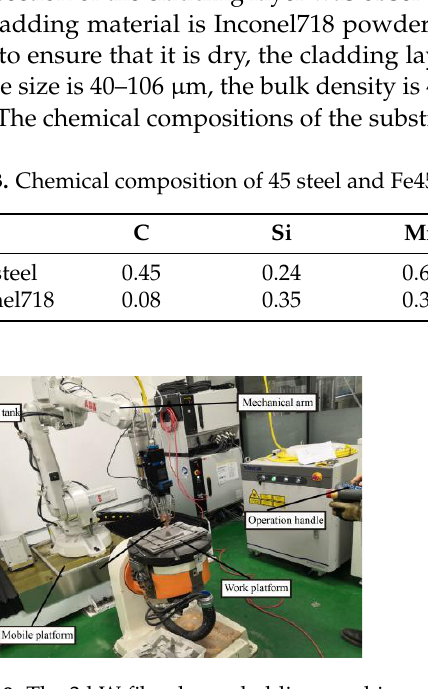
Figure 10. Super-depth-of-field microscope. Figure 11. Microscopic image of Inconel718 alloy powder. According to the previous experimental research, the distance between the nozzle and the surface of the worktable was adjusted to be 25 mm, the radius of the laser spot was 2 mm, the initial preheating temperature was set to 20 degrees, and argon (Ar) was used as the protective gas during the cladding process, shielding gas flow 6~10 L/min. 3.2. Experimental Design and Results During the laser cladding process, the matrix and the cladding powder absorb dif- ferent energy, resulting in different degrees of melting effect of the matrix and the powder. The partially melted matrix material will diffuse into the molten powder, which will have a certain dilution effect on the melted powder melt. We usually use the dilution rate to represent the diffusion result of the matrix material [24]. Within a certain range, the lower the dilution rate, the better, the calculation formula: =